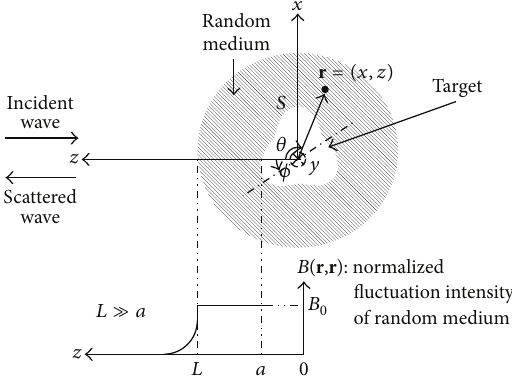
Figure 1: Geometry of the problem of wave scattering from a conducting cylinder in a random